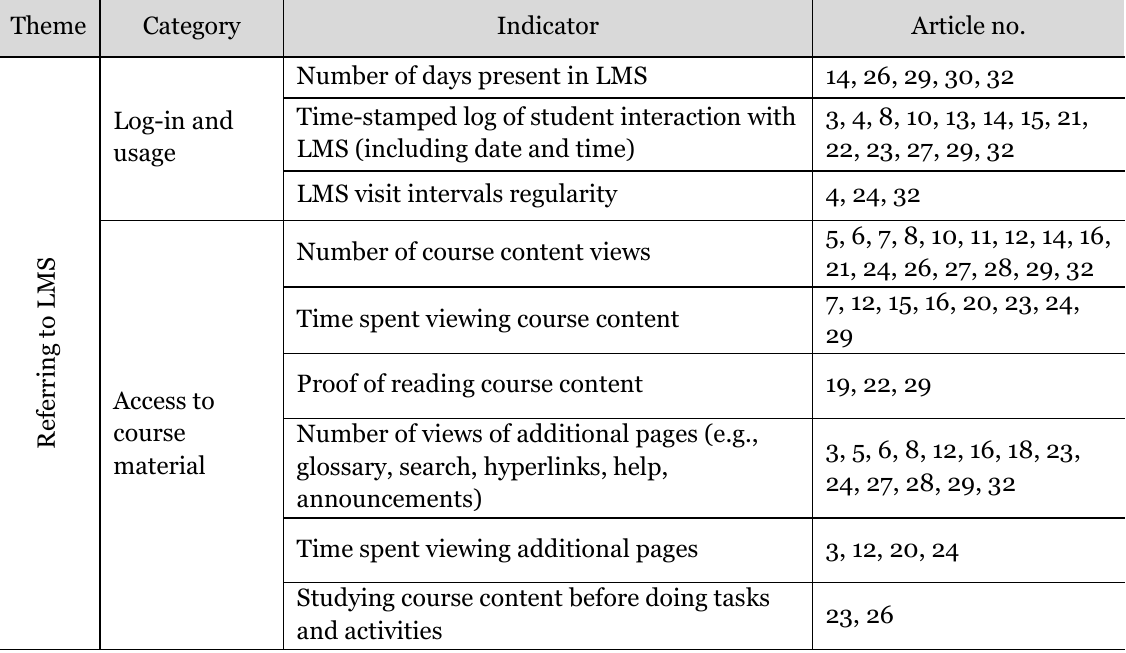
Student Engagement Indicators in LMS and Articles Stating